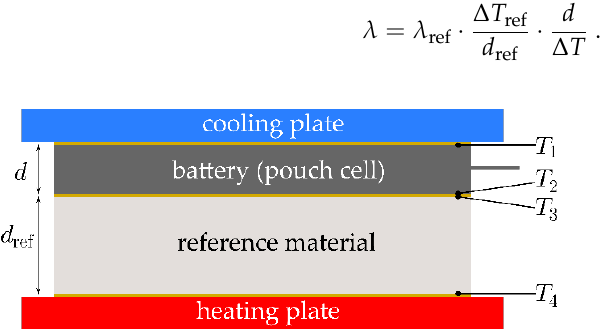
Figure 3. Experimental setup to determine the transversal thermal conductivity of a pouch cell under application of Fourier’s law. Temperatures are measured at positions 1–4.